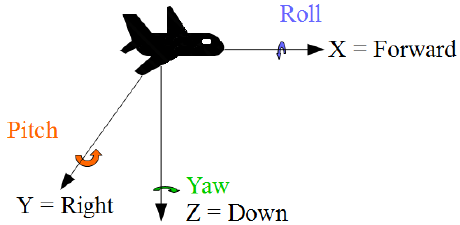
Figure 2. roll, pitch and yaw angles are rotation angles relative to the axis of the body